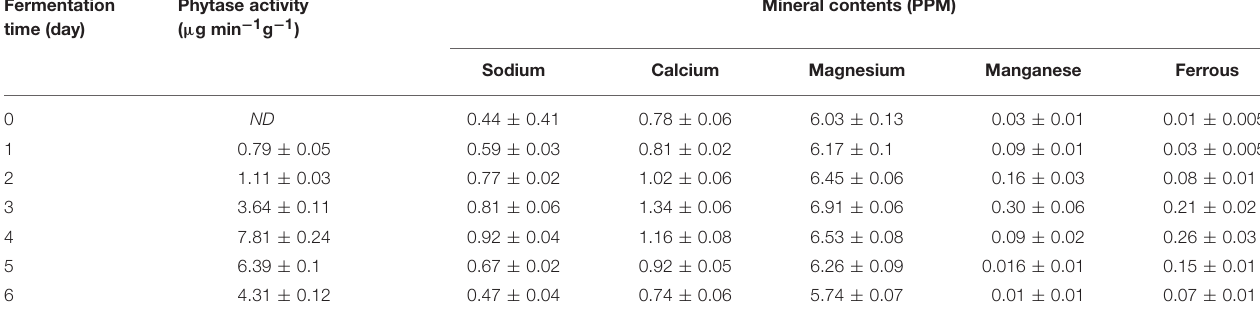
TABLE 6 | Concentration of minerals during the course of rice fermentation. Fermentation time